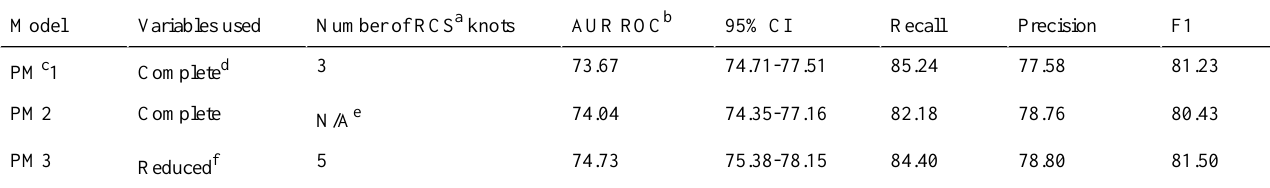
Table 3. Performance of models for glycated hemoglobin elevation